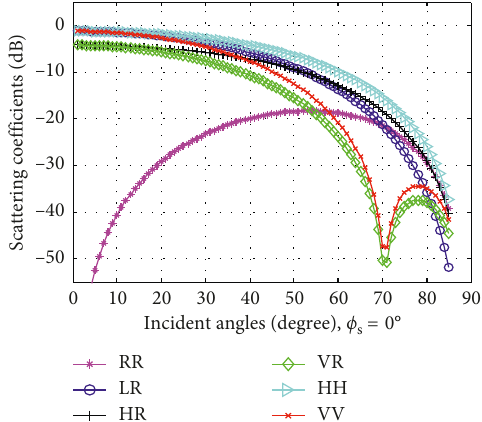
Figure 3: Scattering coefficients of linear polarization and RX polarization vs. incident angles (vms � 0.15).